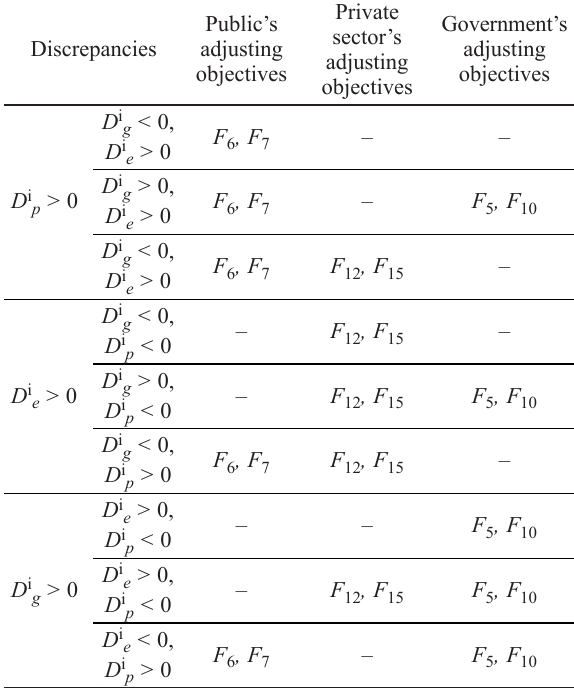
Table 2. Regular satisfaction discrepancies and proposed adjusting objectives in